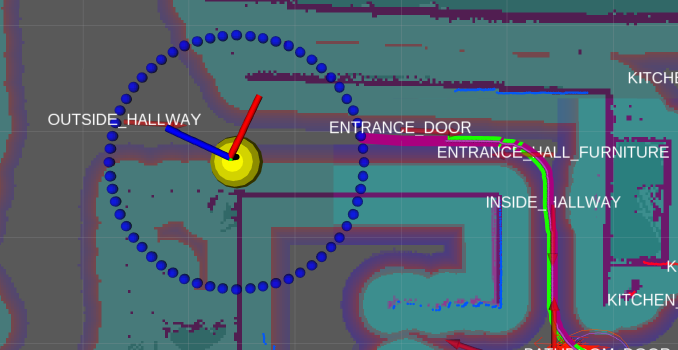
Figure 3. Person following example. The yellow sphere represents the person position, blue spheres represent the possible positions the robot could be at the desired distance to the person and the purple line is the path the robot chose from its position to the chosen target